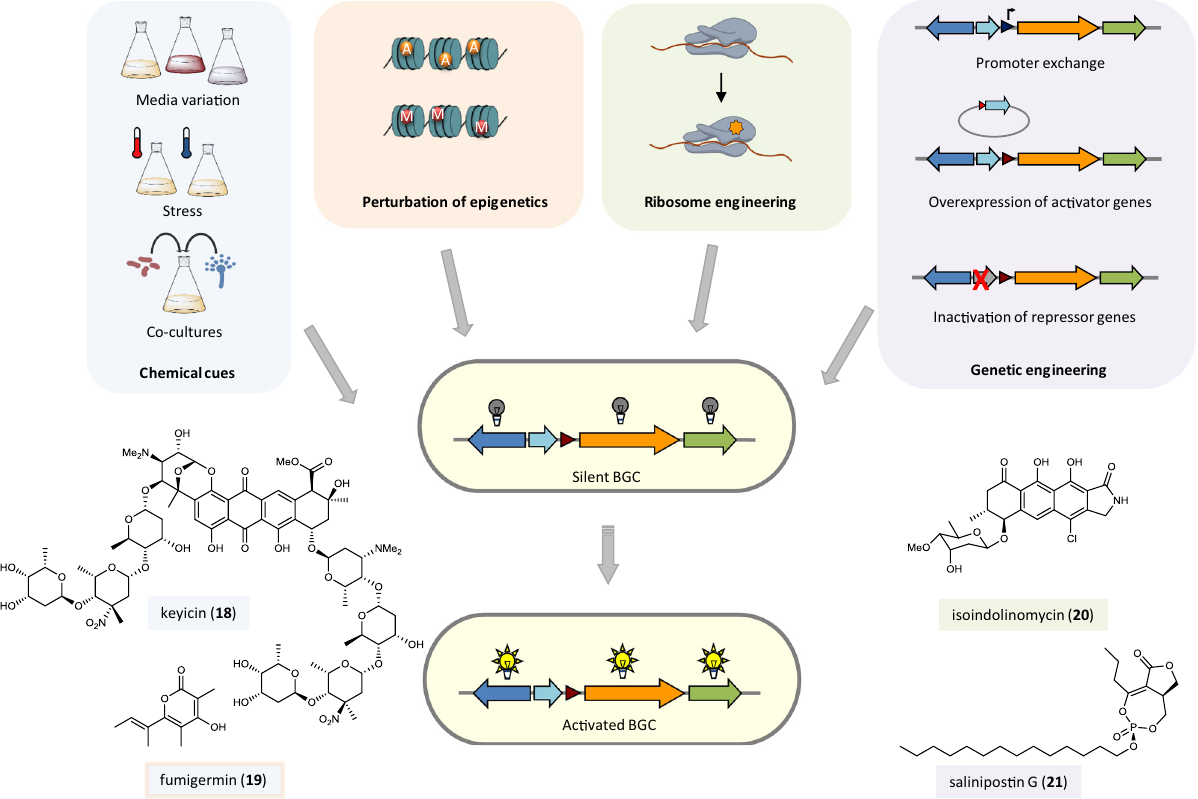
Fig. 2 Accessing cryptic biosynthetic genes in native hosts. Strategies for the activation of silent biosynthetic gene clusters in native hosts and examples of natural products discovered through these methods. (BGC biosynthetic gene cluster). The color code of the boxes around the compound names and icons indicates the strategy that was applied for the discovery of the respective compound: light blue — triggering natural product biosynthesis through chemical cues, light orange — activation of natural product biosynthesis through perturbation of epigenetic regulation, green — activation of natural product biosynthesis through ribosome engineering, light violet — activation of natural product biosynthesis through genetic